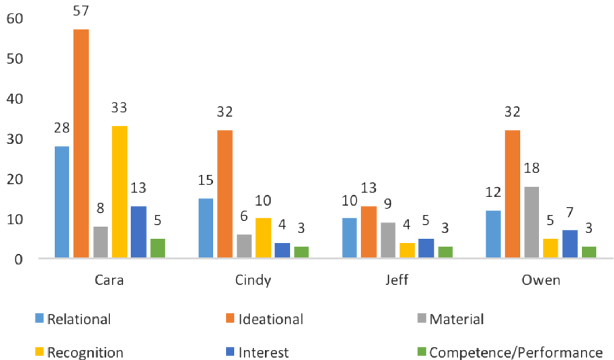
FIG. 6. The code counts for each construct in the Critical Physics Identity framework for each participant.